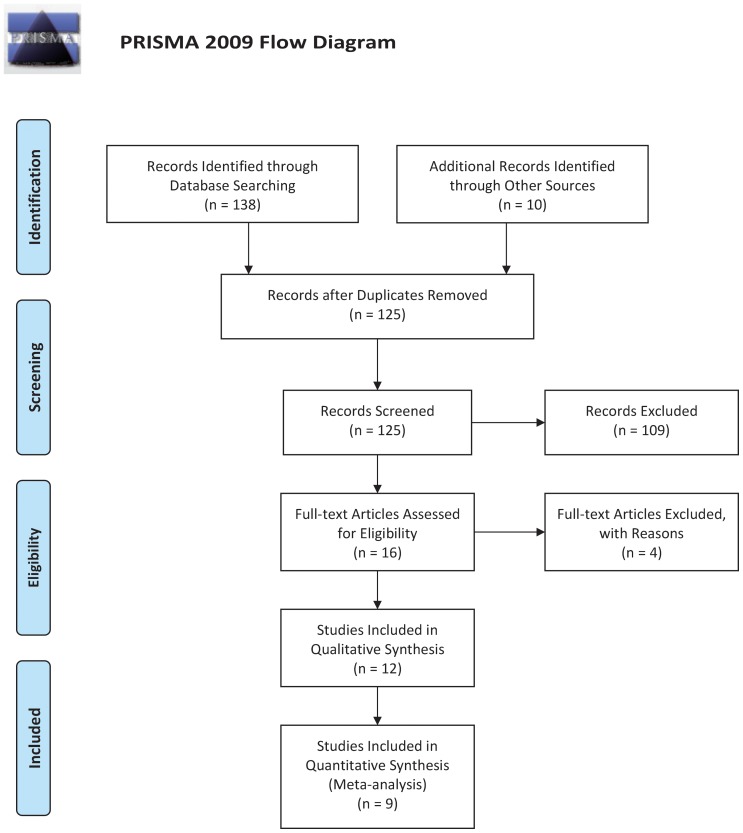
Flow diagram of studies with specific reasons for inclusion/exclusion in the present meta-analysis.